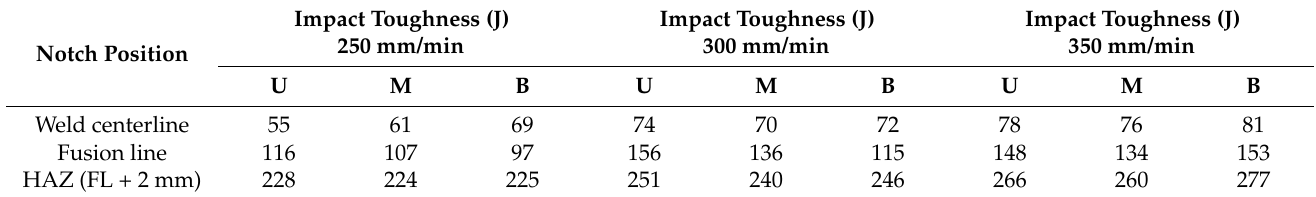
Table 6. Impact toughness of the welded